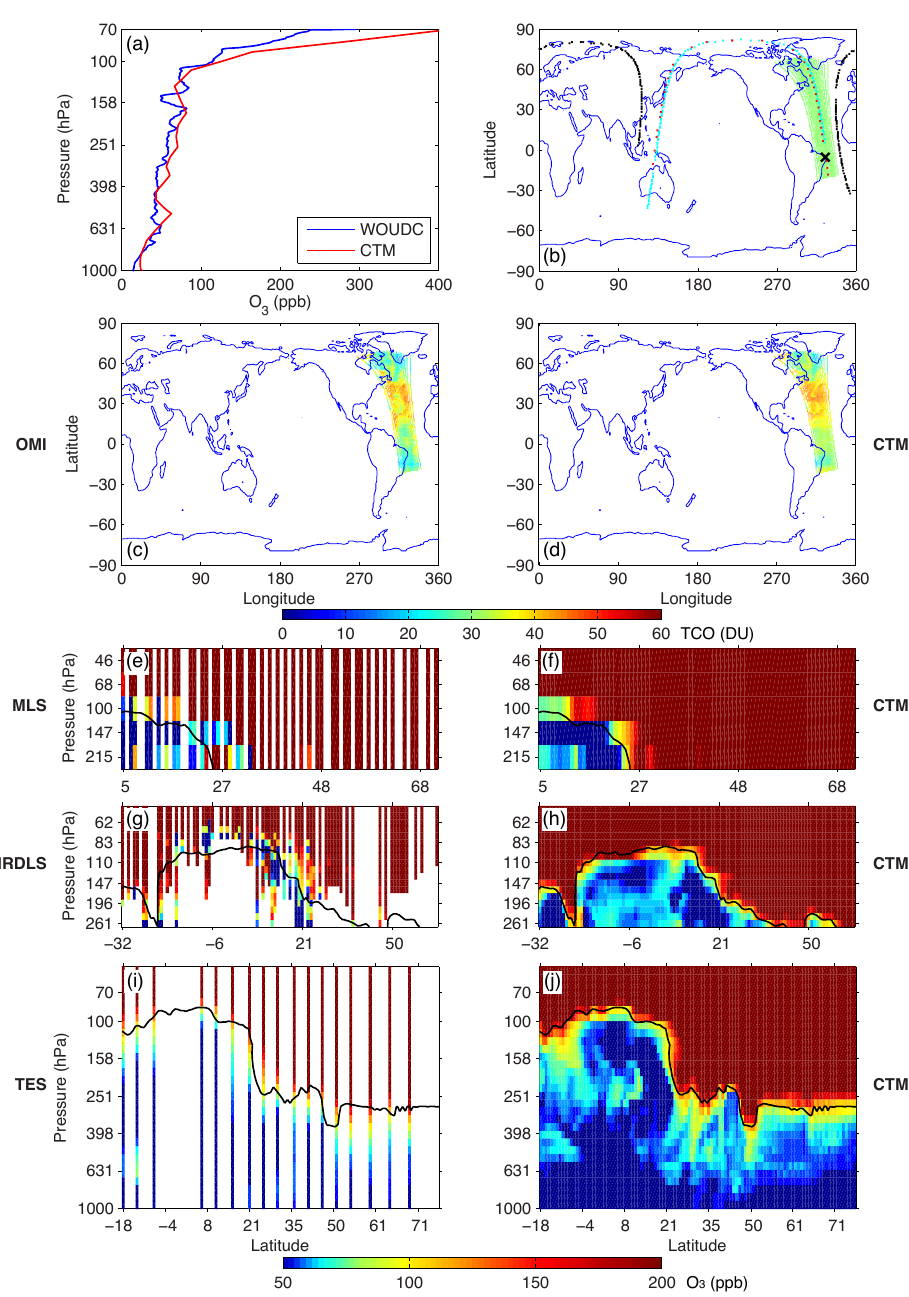
Fig. A5. Same as Fig. 3 for 2 February 2005. The sonde is from Maxaranguape (5.4 ◦ S, 35.4 ◦ W, station code 466) at 15:45UTC, compared with model simulation at 16:00UTC in (a) . The Aura and CTM swaths are for 16:00–17:00UTC. (c) – (j) show the swaths in 251 ◦ E–360 ◦